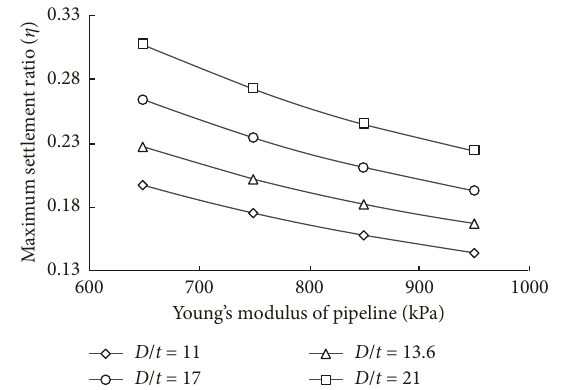
Figure 10: Influence of pipeline Young’s modulus on the maxi- mum settlement ratio.